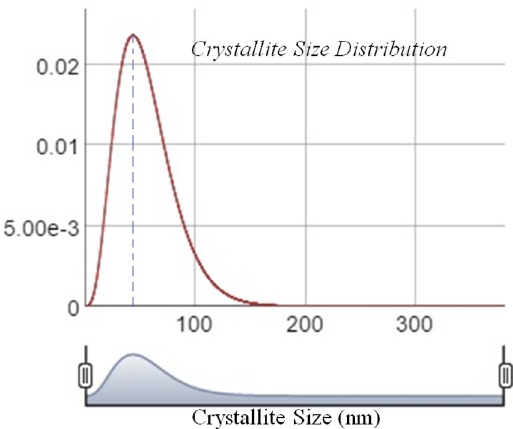
Figure 3. Mean crystallite size calculated by the Scherrer equation.